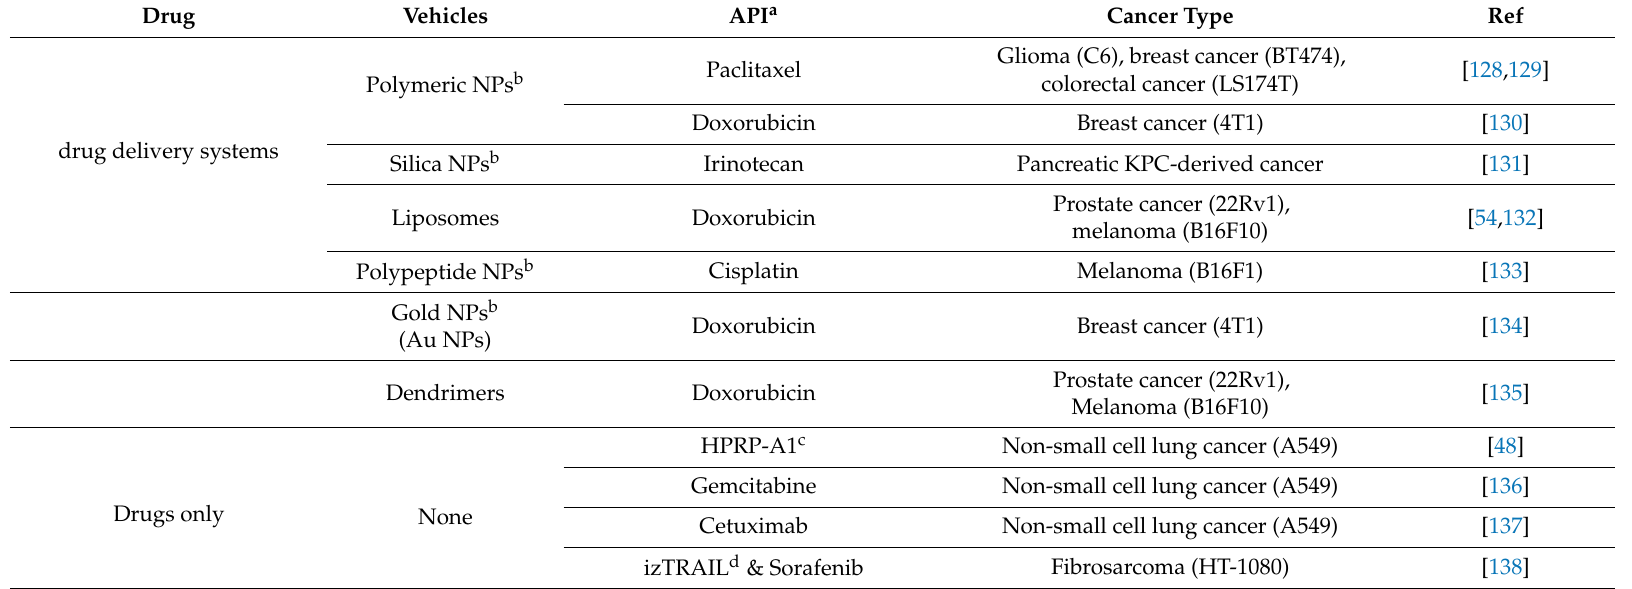
Table 2. Application of iRGD co-administration with therapeutic agents to improve the drug e ffi